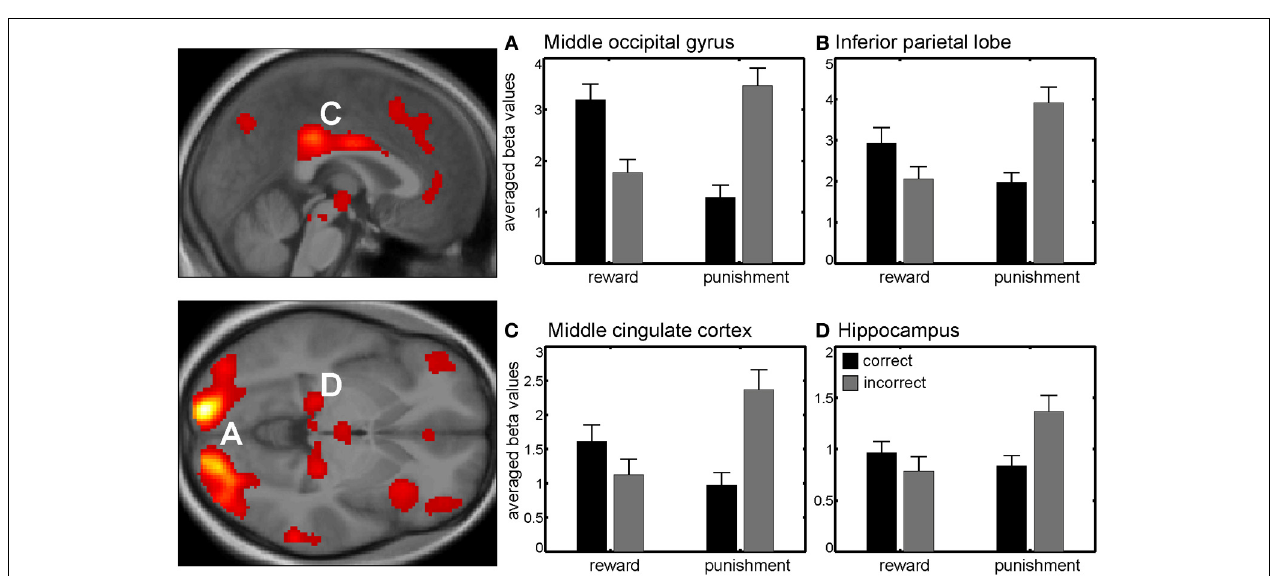
differences are due to higher neural activity in incorrect compared to correct trials. Activations are superimposed on the mean of the individual subject T 1 images for at p < 0 . 001 (uncorr., k > 110 voxels). Note that the extraction of beta values is only illustrative and inferences were made from the original analysis.